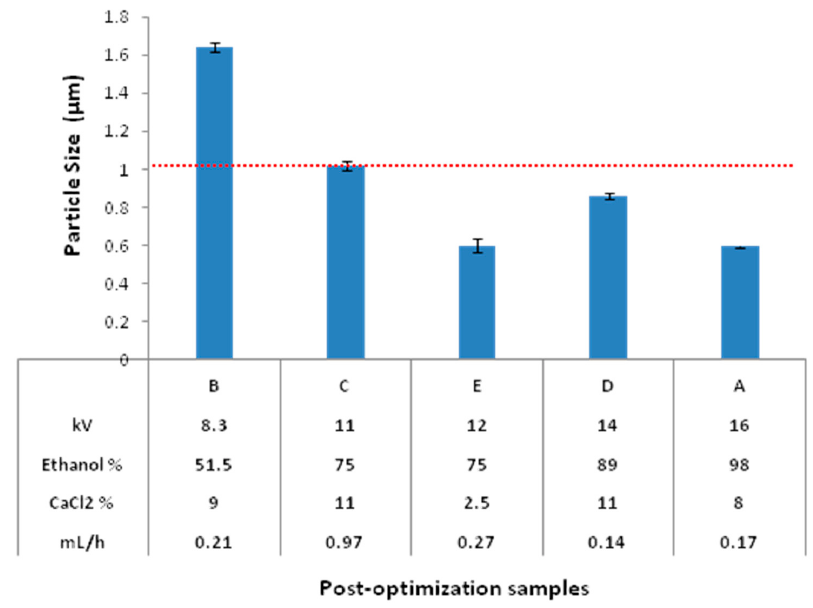
Figure 7. Mean diameters of post-optimization beads for each combination of post-optimization parameters. Error bars indicate standard error of the mean. Horizontal dotted red line indicates the optimal size (1 µm).